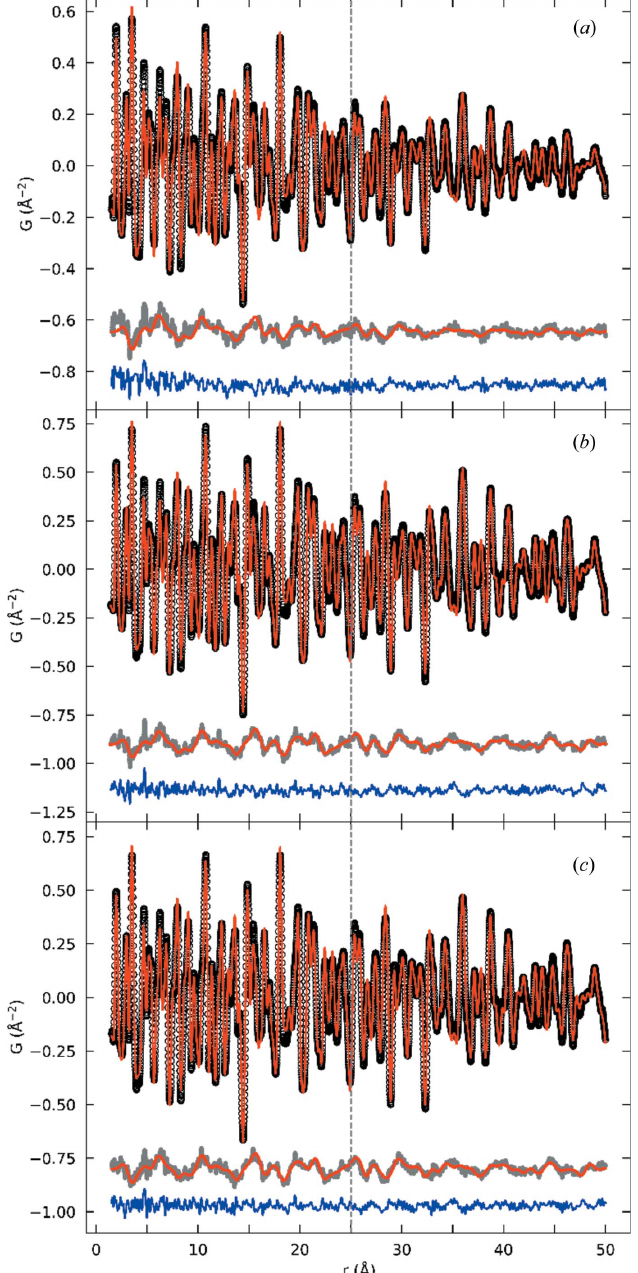
Figure 7 Neutron PDFs obtained from NOMAD data for the three samples synthesized at ( a ) 340, ( b ) 390 and ( c ) 440 (cid:4) C. The data (black) are fitted with the P 4 3 2 1 2 model (red). The difference curve (grey) shows clear oscillations for all three samples owing to well defined magnetic correlations. The red curves overlaid on the grey curves represent the mPDF fits described in the text. The total fit residual after including both the atomic and mPDF components is given by the blue curve in each panel. The vertical dashed line at r = 25 A˚ marks the division between the two fitting ranges used (1.5–25 and 25–50 A˚